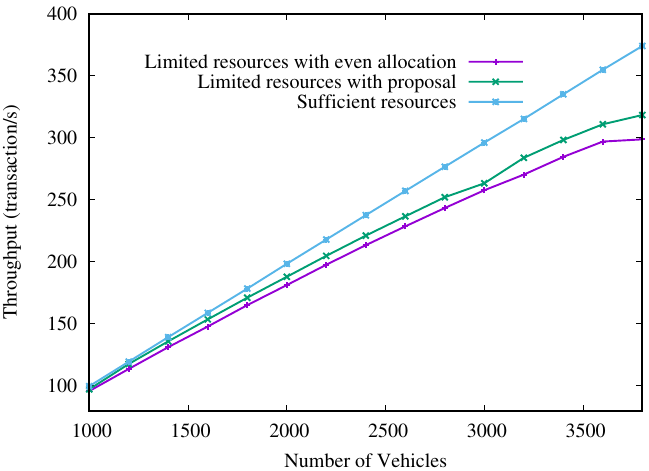
Figure 9. Throughput performance of the system without coexisting